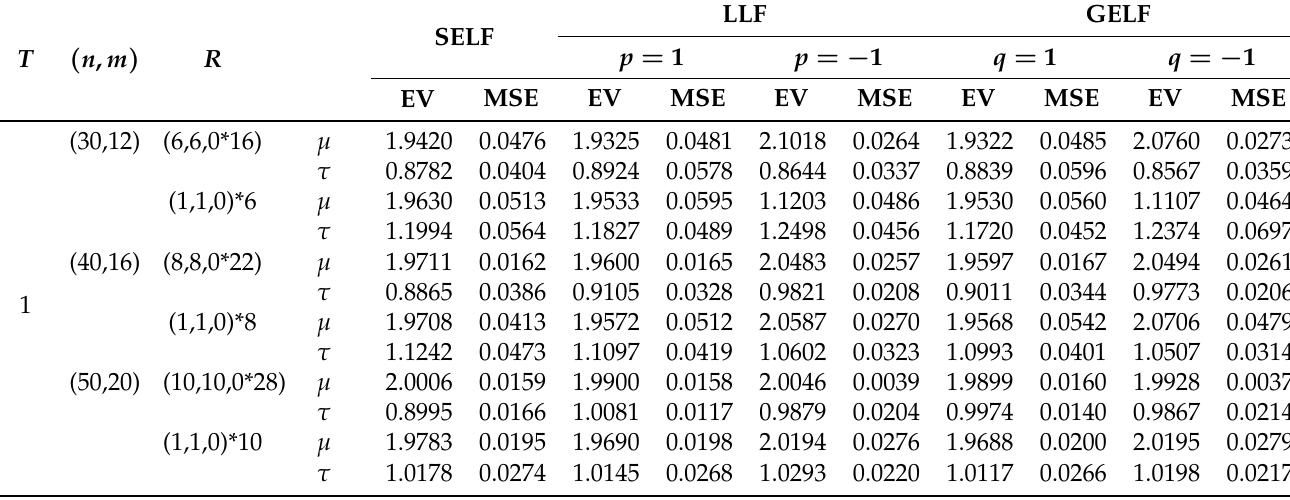
Table 2. The Bayesian estimation results using importance sampling under SELF, LLF and